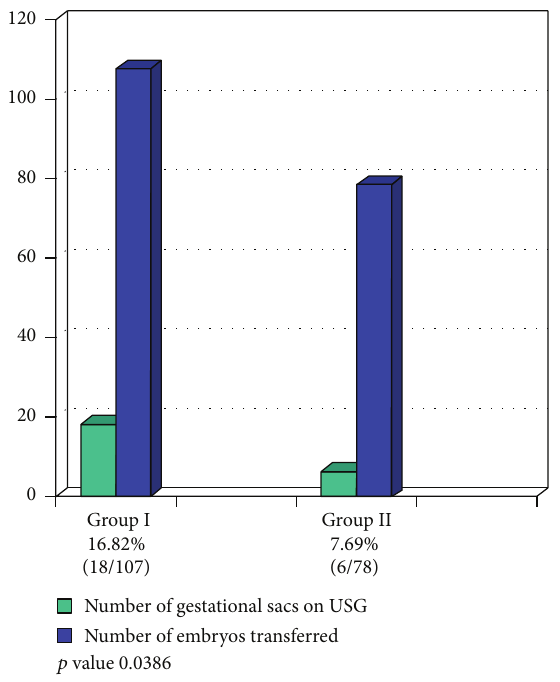
Figure 3: Implantation rates in patients receiving progesterone for 3 and 4 days before embryo